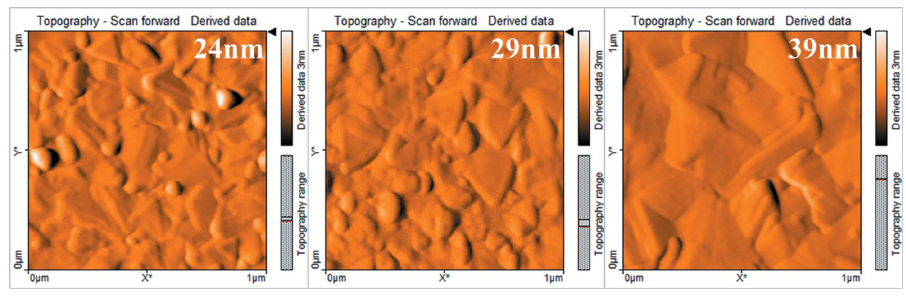
Figure 7 AFM images (1 (cid:4) 1 m m) of Bi thin films with different thicknesses of 24, 29 and 39